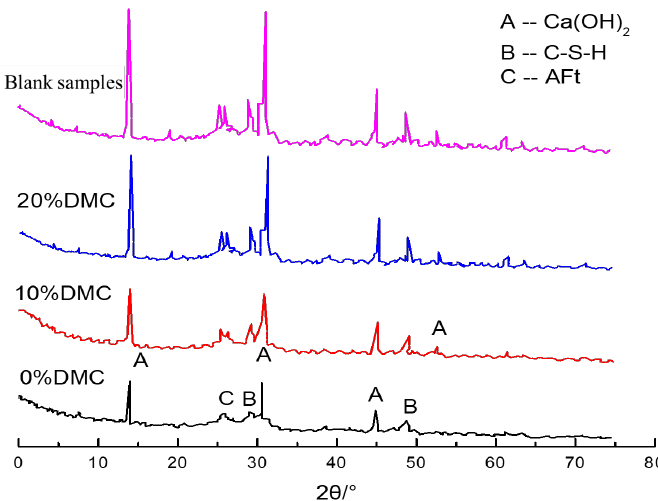
Figure 10. XRD patterns of cured cement with different